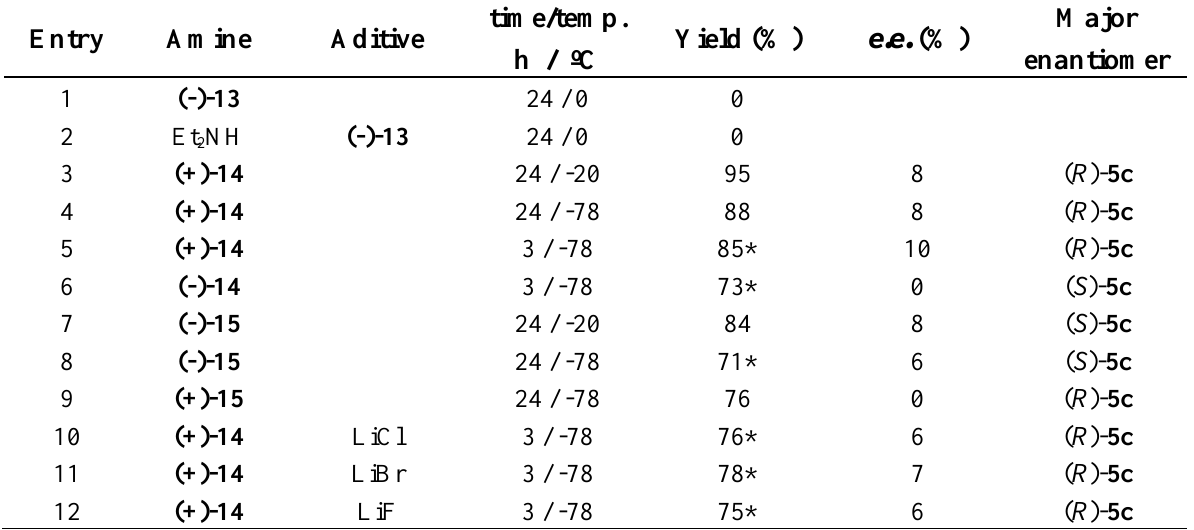
Table 2 . Addition of phenylacetic acid dianion to bromoacetonitrile using chiral lithium amides as